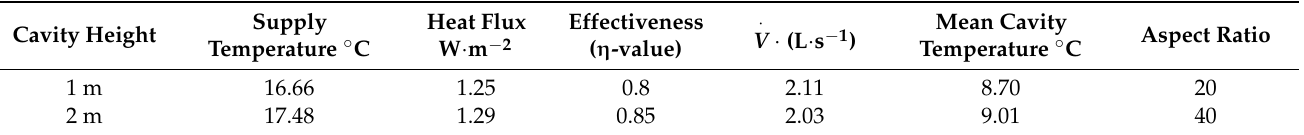
Table 5. Supply air temperature, heat flux, effectiveness, volumetric flow rate, and mean cavity temperature for the ventilated windows with two cavity height assumptions.